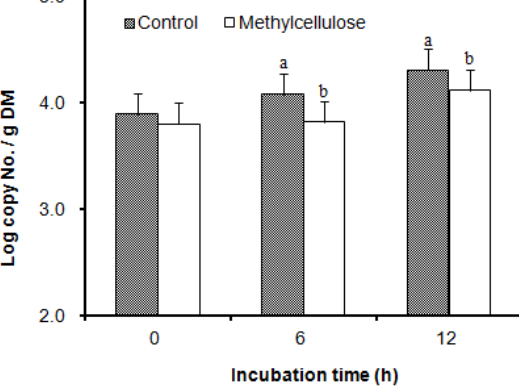
Figure 4. The DM digestibility of rice straw as influenced by methylcellulose addition after 8 h of incubation. a,b Means with different letters differ significantly (p<0.05).